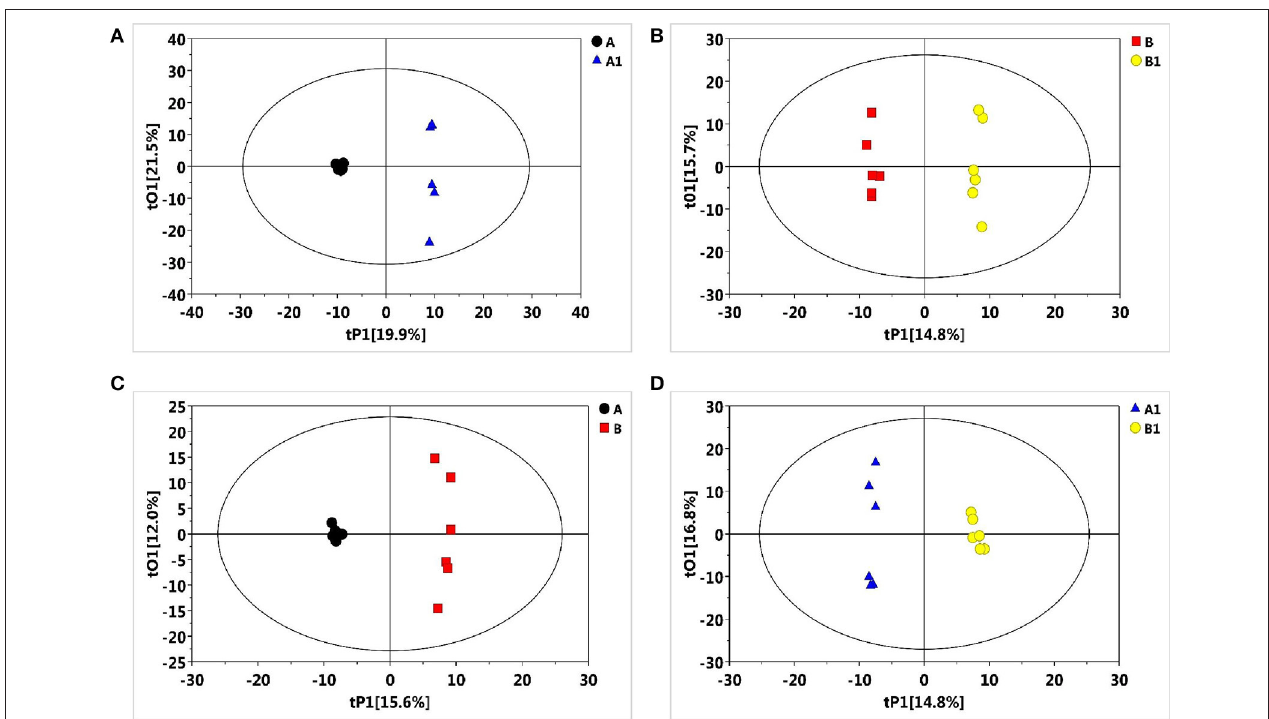
FIGURE 4 | Partial least squares-discriminate analysis (PLS-DA) score plots of metabolic profiles in alfalfa roots under the alkali stress. (A) PLS-DA score plot for NI control (black), NI alkali-treated (blue) samples, (B) PLS-DA score plot for RI control (red) and RI alkali-treated (yellow) samples, (C) PLS-DA score plot for NI control (black) and RI control (red) samples, (D) PLS-DA score plot for NI alkali-treated (blue) and RI alkali-treated (yellow) samples.